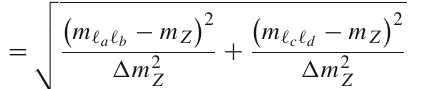
Fig. 2 Higgsproductioncrosssections(assumingSM-likepropertiesfor H ) σ SM √ s = 3000 GeV (right), for unpolarized beams (solid) and P e − , P e + = − 80% , + 30% (dashed) GeV (middle) and